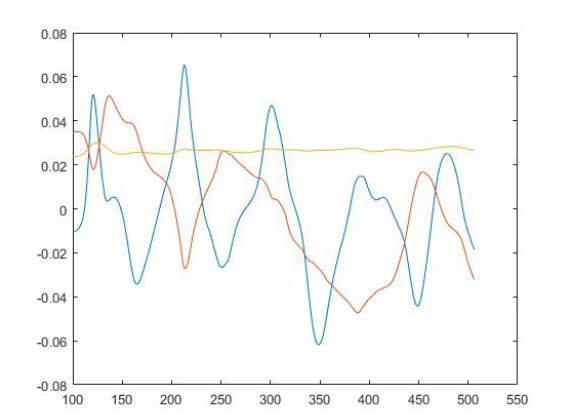
Fig. 27. The first three principal components for 50 cells in geometry A, seeding b.